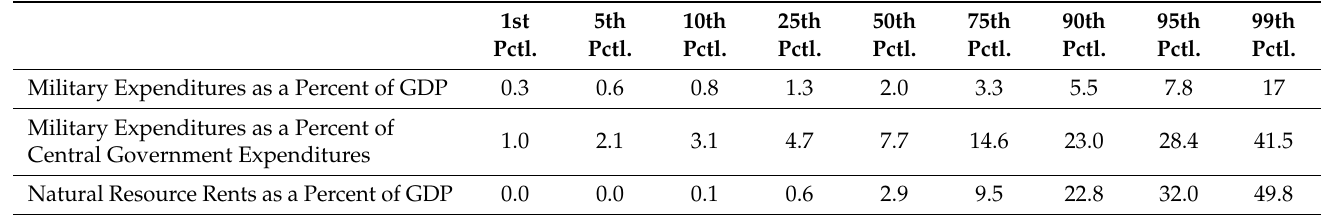
Table A2. Distribution of Military Expenditures and Natural Resource Rents.